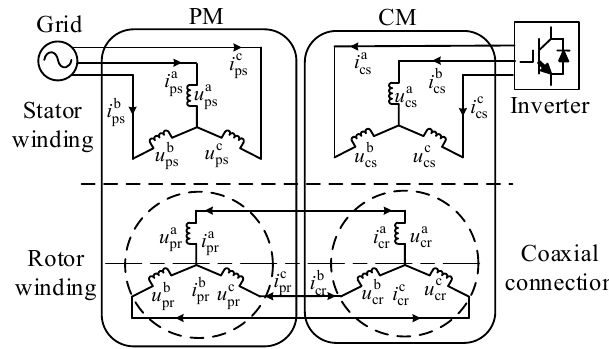
Figure 1. Schematic diagram of BDFM.